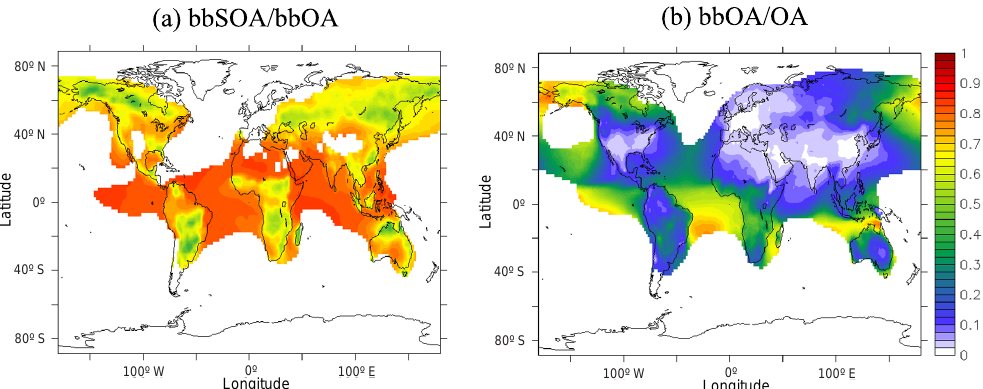
Figure 8. Predicted ratio of (a) biomass burning SOA (bbSOA) to total biomass burning OA (sum of bbPOA and bbSOA) and (b) biomass burning OA to total OA (sum of fOA, bbOA, aSOA, and bSOA) during the years